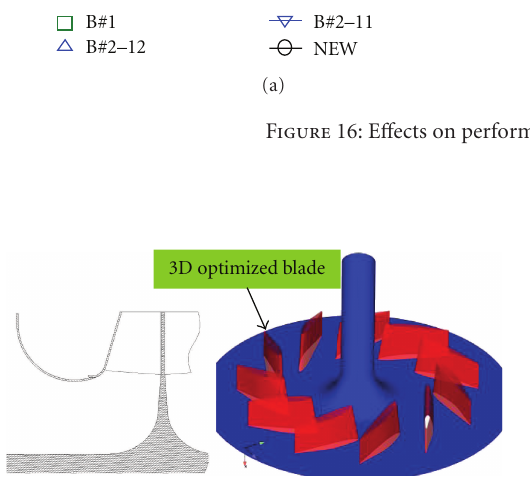
Figure 17: The integrated new design impeller NEW.